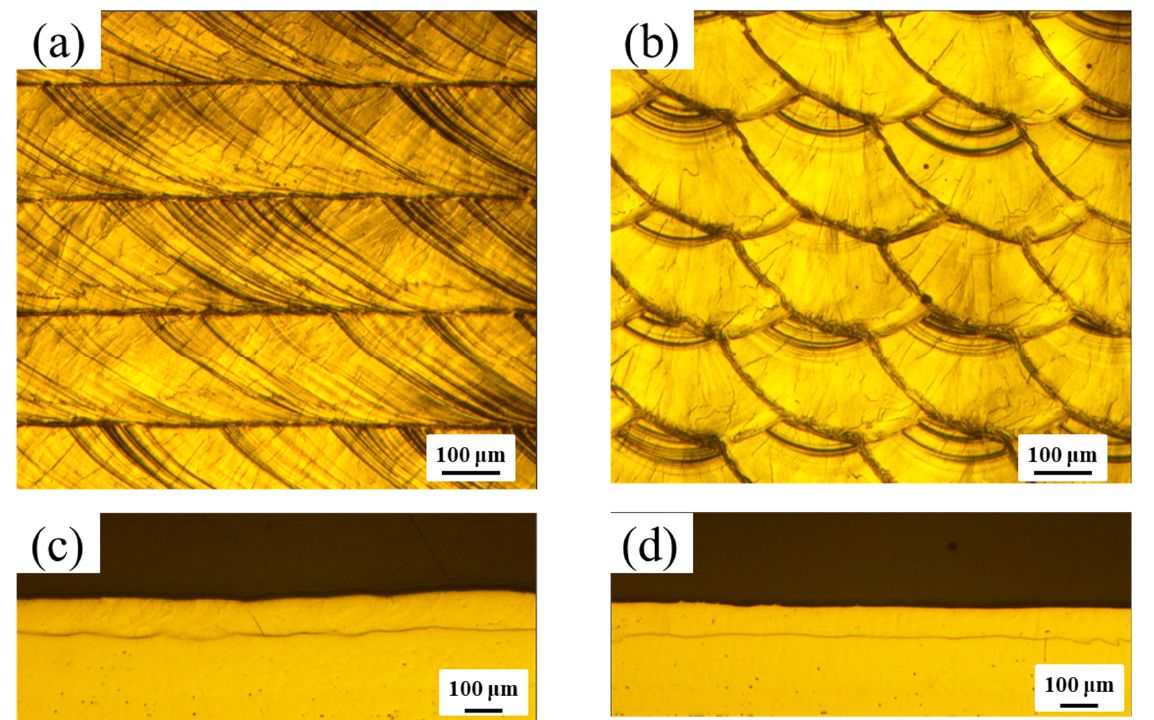
Figure 3. Single-layer surface morphologies of ( a ) LS and ( b ) WBS and ( c , d ) the cross-sectional morphologies of ( a , b ), respectively.